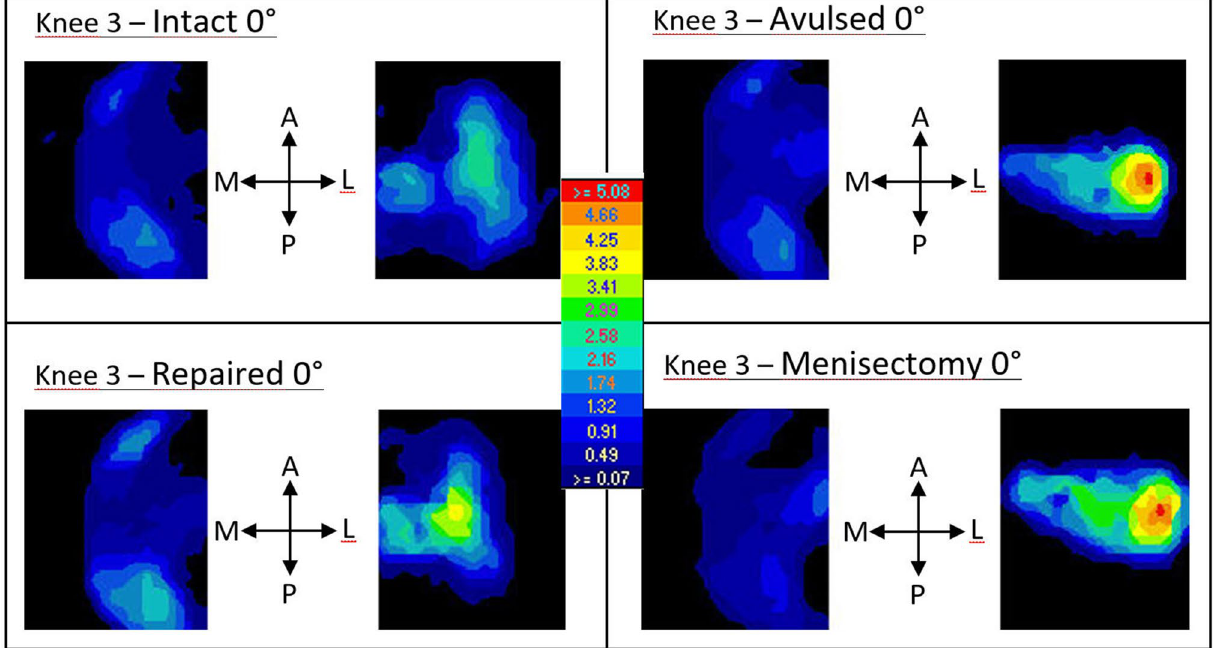
Figure 3. Representative distribution of pressures in the lateral and medial compartments. The four lateral meniscus conditions tested are represented for specimen n° 3 at 0° of flexion: anterior root avulsion of the lateral compartment resulted in a more concentrated distribution of pressures in the injured side, with steeper gradients. These effects were similar to meniscectomy. With repair, pressure distribution tended to recovered that of the intact